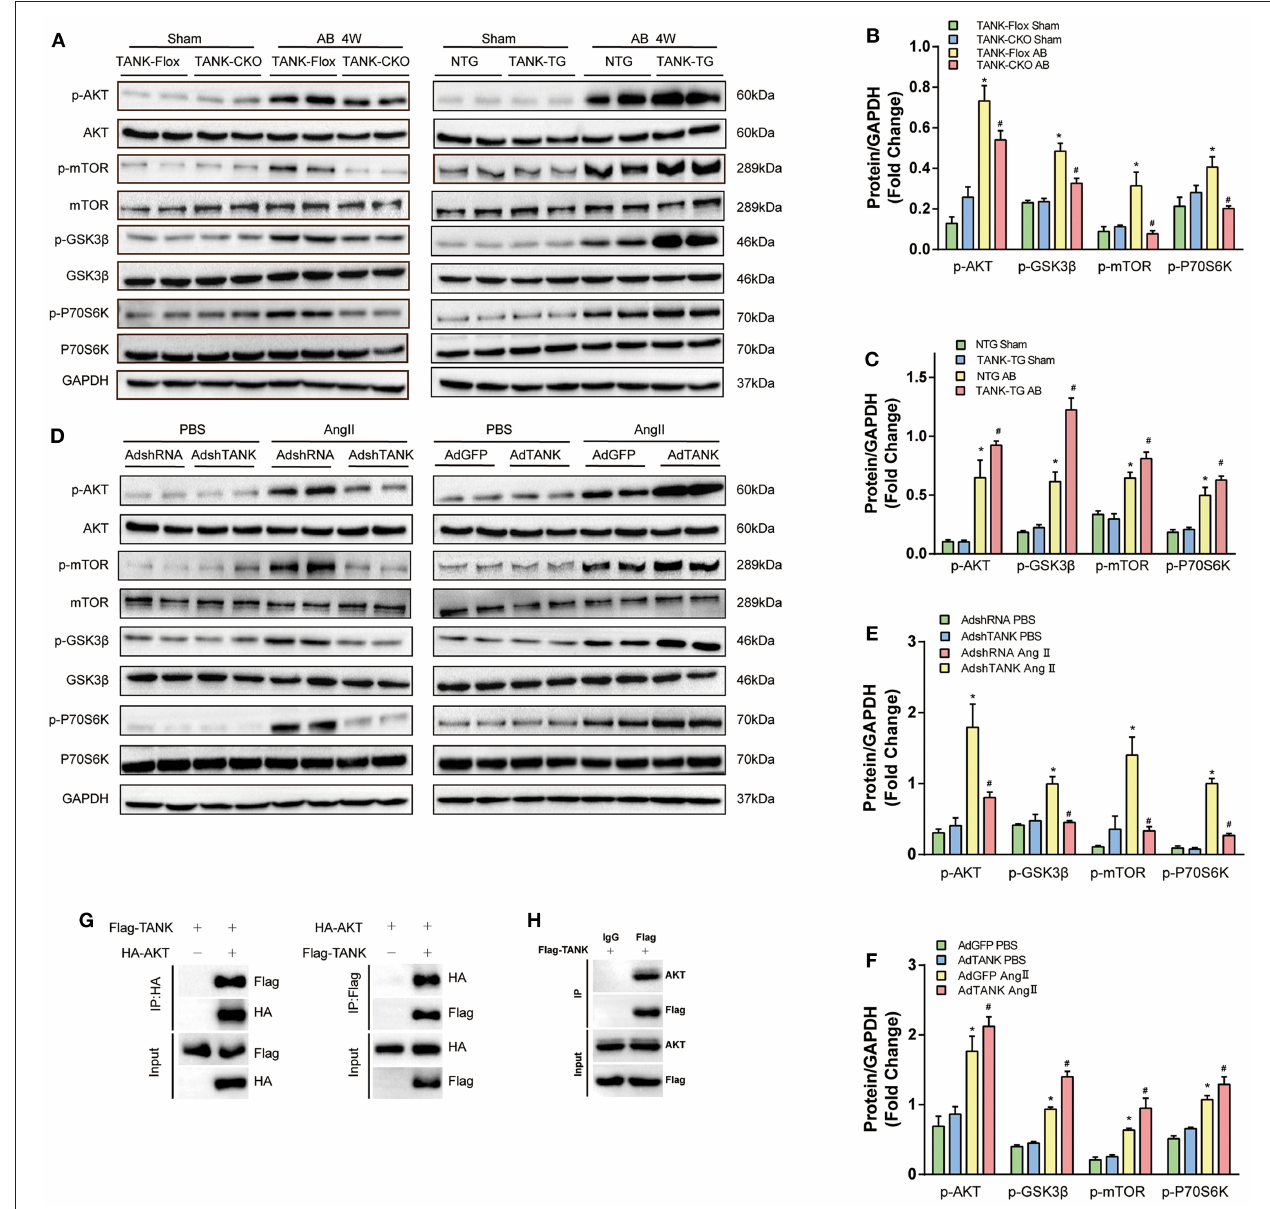
FIGURE 6 | TANK promotes AKT phosphorylation in vivo and in vitro . (A) Representative Western blot showing total and phosphorylated expression of AKT, GSK3 β , mTOR, and P70S6K in TANK-CKO mice compared with TANK-Flox mice (Left) or TANK-TG mice compared to TANK-NTG mice (Right) subjected to sham or aortic banding for four weeks. (B ,C) Quantitative analysis of the phosphorylation of AKT, GSK3 β , mTOR, and P70S6K in TANK-Flox and TANK-CKO mice (B) or in TANK-NTG and TANK-TG mice (C) ( n = 4 per group; * P < 0.05 vs. TANK-Flox/Sham or TANK-NTG/Sham; # P < .0.05 vs. TANK-Flox/AB or TANK-NTG/AB). (D) Representative Western blot for the AKT signaling-related protein from NRCMs infected with AdshRNA as the control and AdshTANK to delete TANK expression (Left) or AdGFP as the control and the AdTANK group to overexpress TANK protein (Right) treated with PBS or Ang II. (E,F) Quantitative analysis of phosphorylated AKT signaling-related protein in the AdshRNA and AdshTANK groups (E) or the AdGFP and AdTANK groups (F) ( n = 3 independent experimens; * P < 0.05 vs. AdshTANK/PBS or AdGFP/PBS; # P < 0.05 vs. AdshTANK/Ang II or AdGFP/Ang II). The data are presented as the mean ± SD. (G,H) Immunoprecipitation followed by immunoblotting revealed that TANK interact with